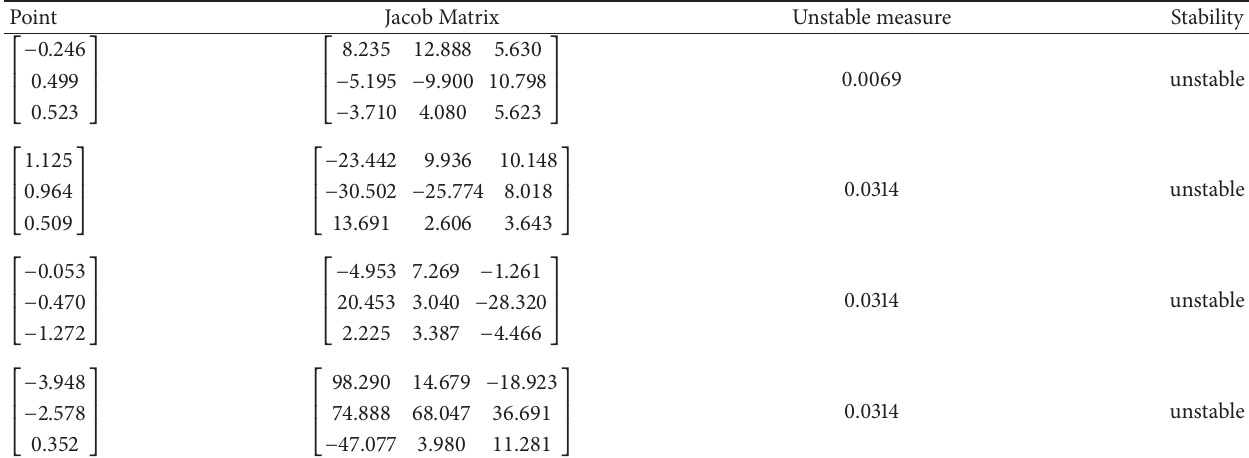
Table 3: Results about stability analysis of economic system about